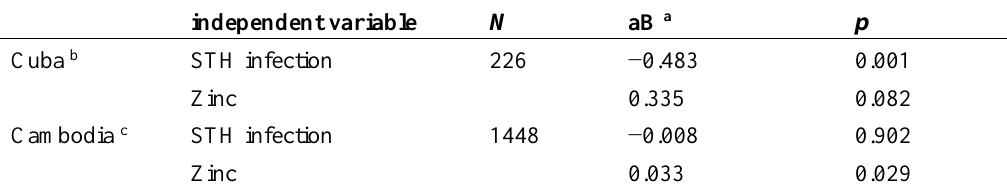
Table 3. Linear regression models of height for age by STH infection and zinc.